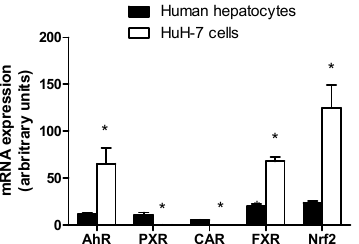
Figure 5. Nuclear receptor mRNA expression in HuH-7 cells. mRNA expression of the receptors aryl hydrocarbon receptor (AhR), pregnane X receptor (PXR), constitutive androstane receptor (CAR), farnesoid X receptor (FXR) and nuclear factor erythroid 2-related factor 2 (Nrf2) was determined by RT-qPCR in human hepatoma HuH-7 cells and in freshly isolated human hepatocytes. Data are expressed as arbitrary units and are the means + SEM from at least three independent assays (HuH-7 cells) or from three independent populations (human hepatocytes). * p < 0.05 when compared to nuclear receptor mRNA expression level found in freshly isolated human hepatocytes (Student’s t -test).